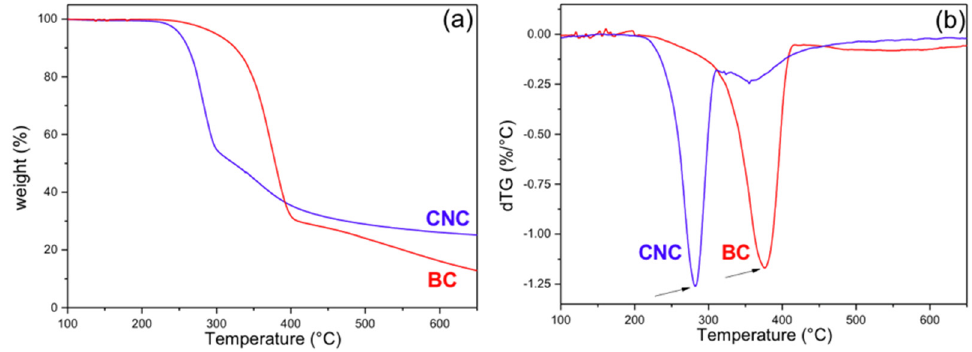
Figure 4. ( a ) Thermal degradation curves (thermogravimetric (TG) curves); ( b ) derivative signal (dTG) obtained under N 2 atmosphere for the BC and the CNCs.